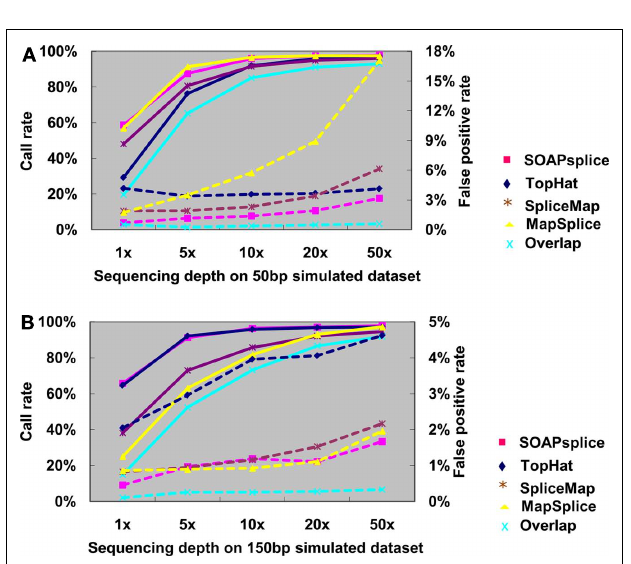
FIGURE 2 |Three typical kinds of spliced alignment with read length of 100bp. read (A) represents spliced alignment without segmentation of reads. This alignment can only report one junction from a single read due to the two-segment algorithm in spliced alignment. read (B) is applied only to reads longer than 50bp, and predicts multiply junctions from a single long read with